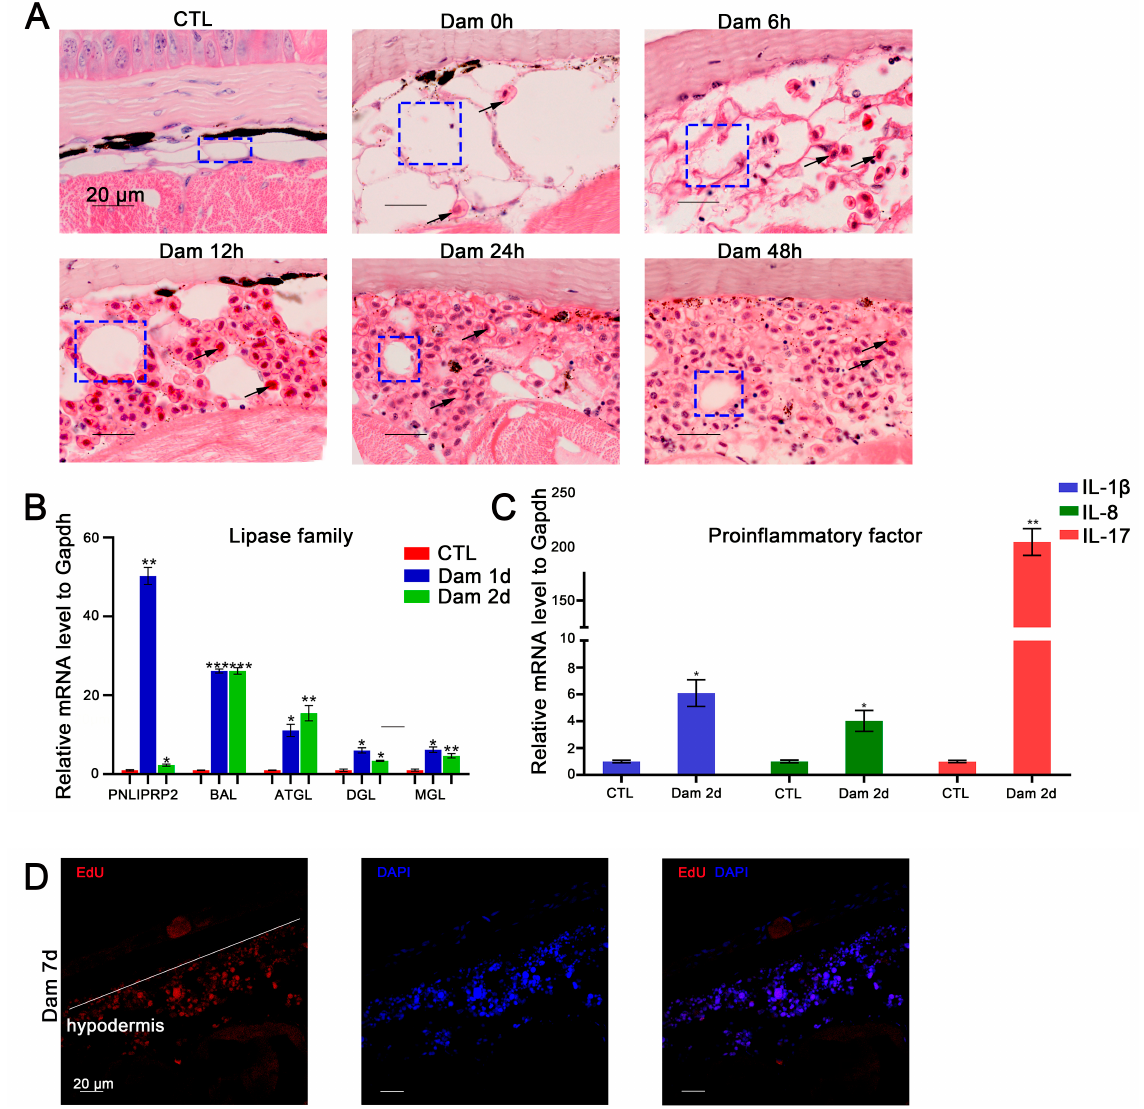
Figure 5. Functional analysis of red blood cells (RBCs) and adipocytes after epidermal damage. ( A ) H&E staining of RBC infiltration in the subcutaneous adipose layer after damage; lipolysis of adipocytes (blue box), gradual infiltration of RBCs (black arrow). Scale bars, 20 µ m. ( B ) The significantly changed lipase genes in the RNA-seq data were verified by RT–PCR. ( C ) Results of RT–PCR analysis of proinflammatory factors in RBCs. * p < 0.05 versus CTL, ** p < 0.01versus CTL, *** p < 0.001 versus CTL. ( D ) EdU proliferation staining results of infiltrating cells in the subcutaneous fat layer. Scale bars, 20 µ